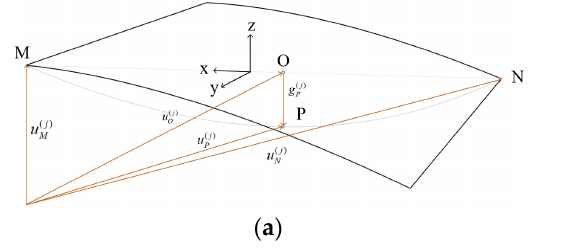
Figure 5. Schematic diagram of contact boundary deformation coordination conditions. ( a ) Intrusion of target and contact surfaces; ( b ) Modification to meet bound contact.